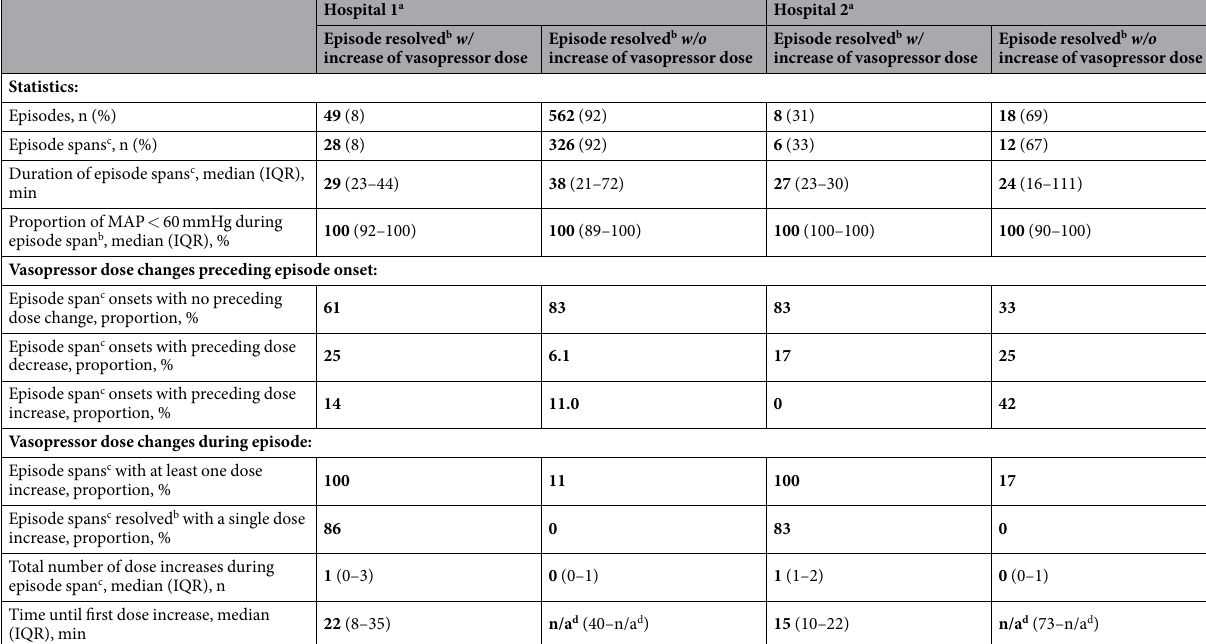
Table 3. Vasopressor dosing before and during sustained episodes of hypotension. a Hospital 1 includes patient data from the MIMIC II database and Hospital 2 includes patient data from a separate medical center. b Episodes of hypotension were categorized as “resolved with increase of vasopressor dose” if there was a vasopressor dose increase within 30 min of the resolution of the episode. c A sustained ( > 15 min) episode of hypotension that followed within 30 min another sustained hypotensive episode was regarded as a continuation of the previous episode and was merged and called an episode span. d n/a signifies that there was no increase, at all, in vasopressor dose during the episode.